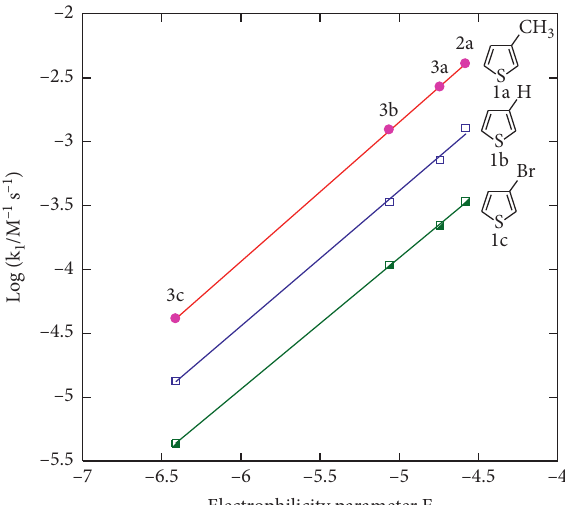
− 1 · s − 1 ) and electro- 1 /M